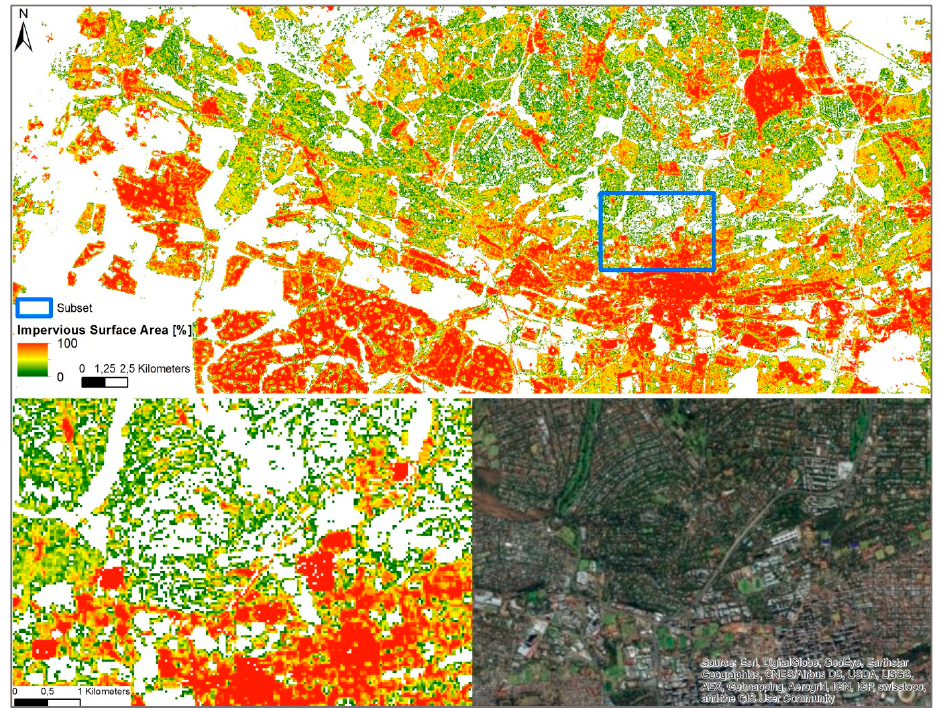
Figure 7. GUF-DenS layer covering Johannesburg in South Africa and subset comparing the layer with high resolution imagery.